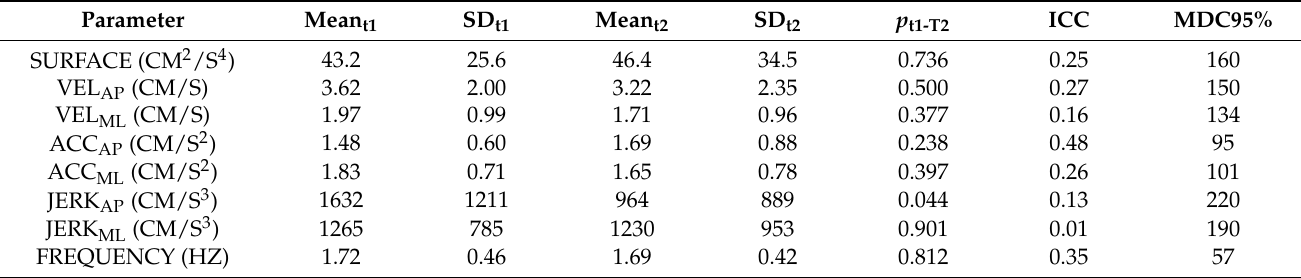
Table 3. Reliability and minimal detectable change: tandem stance on a hard surface ( n =